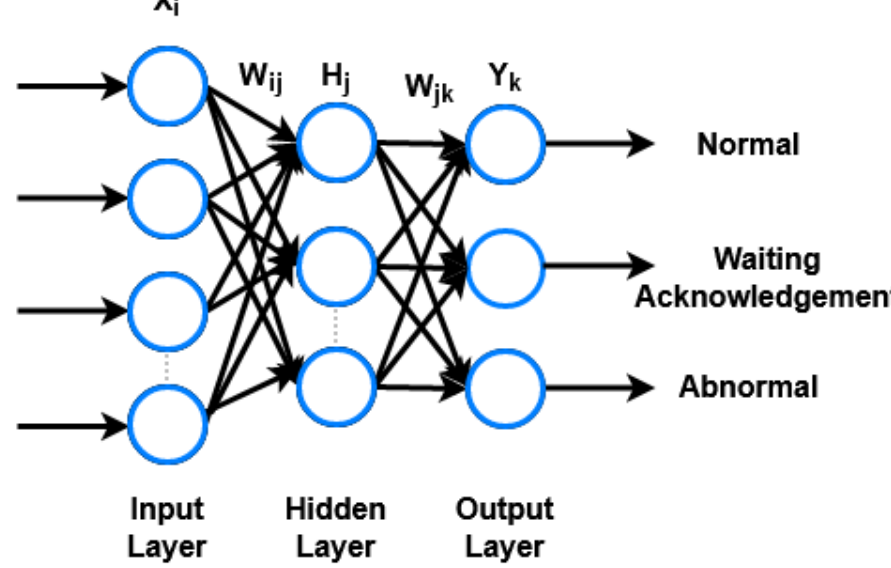
Figure 6. Architecture of neural network classification